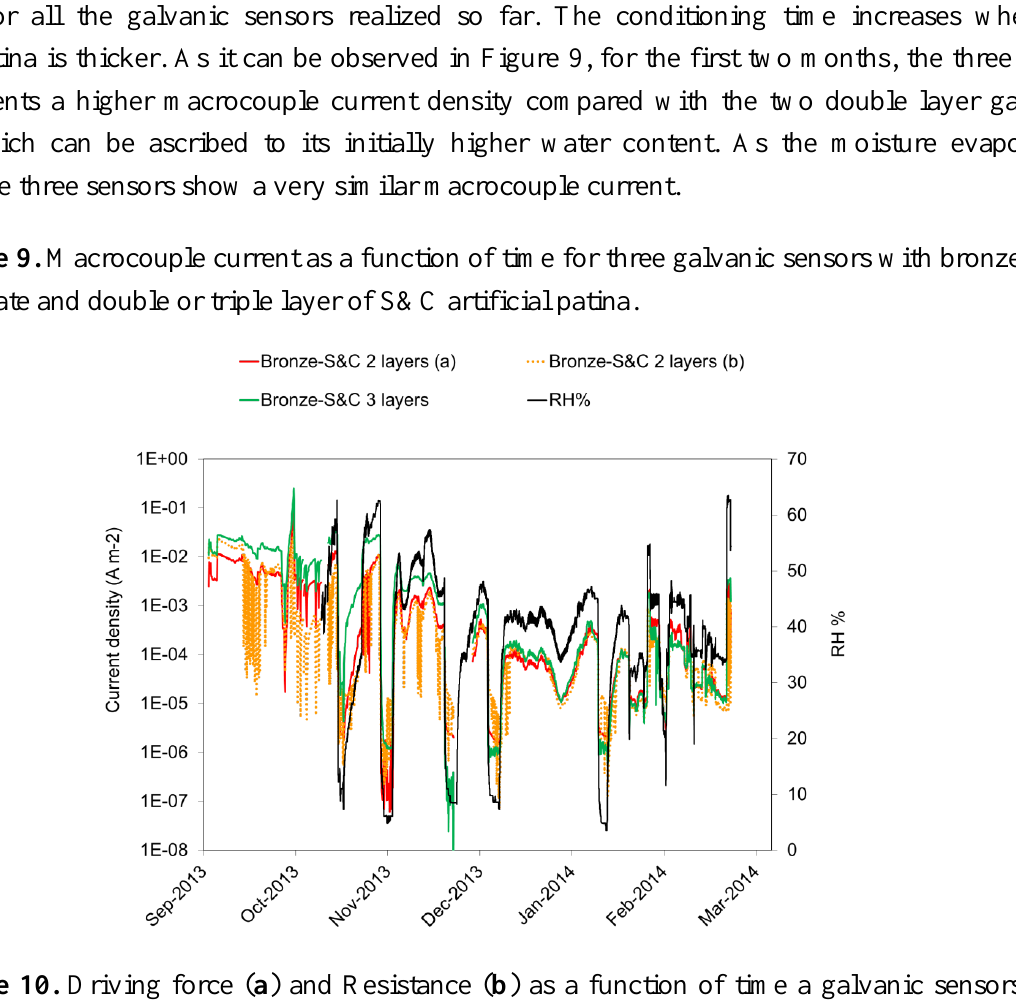
Figure 10. Driving force ( a ) and Resistance ( b ) as a function of time a galvanic sensors with bronze substrate and triple layer of S&C artificial